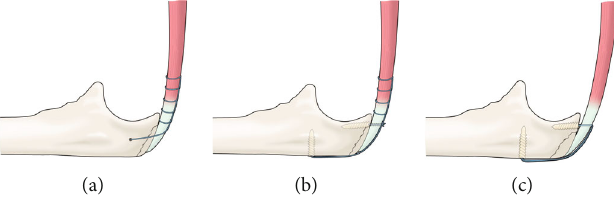
Figure 4: Schematic illustration for the repair of triceps tendon rupture or avulsion. The conventional transosseous technique involves passing nonabsorbable sutures placed in the triceps tendon through bone tunnels in the olecranon and tying them together over a bony bridge (a). In the suture anchor technique described by Yeh et al., the triceps tendon is repaired using four suture anchors and nonabsorbable sutures placed in the triceps tendon (Yeh et al., 2010) (b). Most of the reports about conventional transosseous or suture anchor technique have used the Krackow whipstitch technique for the triceps tendon (a, b). In our patient, the avulsed fragments and triceps tendon were reduced and fi xed using the suture bridge technique after suture anchors were inserted proximal and distal to the ulnar fracture site (c).